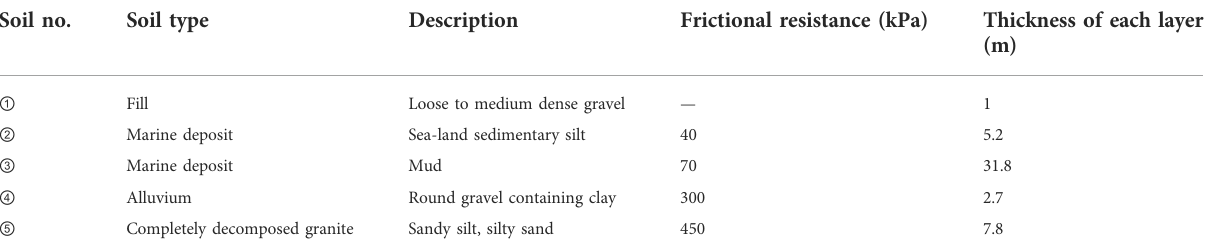
TABLE 1 Geological pro fi les.